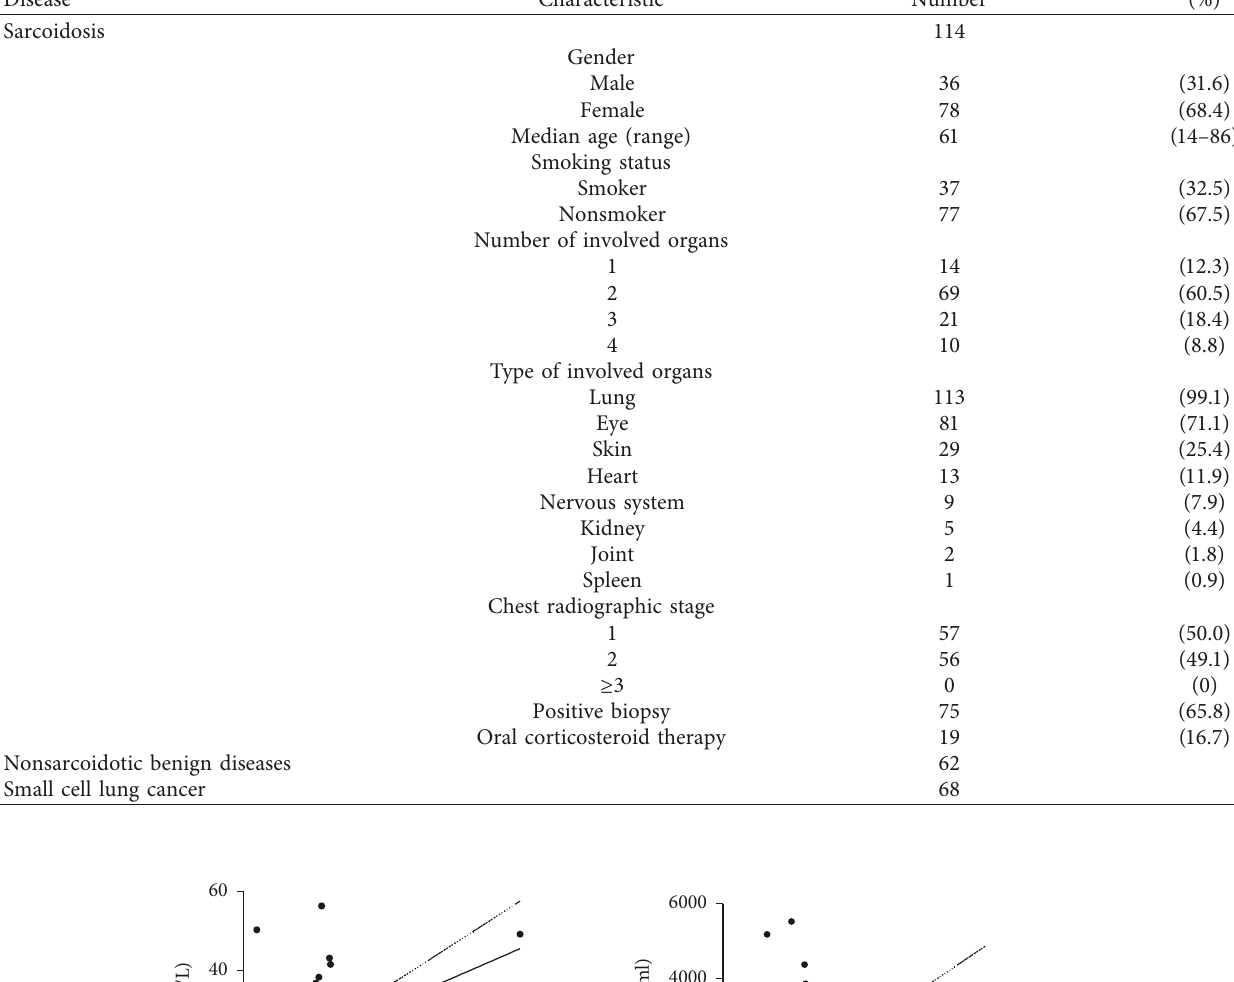
Table 1: Characteristics of patients in the present study.